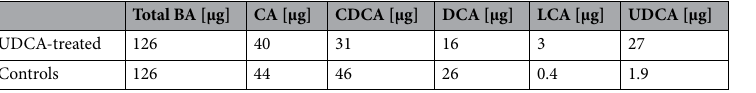
Table 2. Estimate of the BA load in the presumed daily intake of human milk (100 mL) of breast-feeding women treated with UDCA. As a daily dose, 100 mL of human milk was used to assess the newborn´s load of ingested BA 16 . BA, bile acids; CA, cholic acid; CDCA, chenodeoxycholic acid; DCA, deoxycholic acid; LCA, lithocholic acid; UDCA, ursodeoxycholic